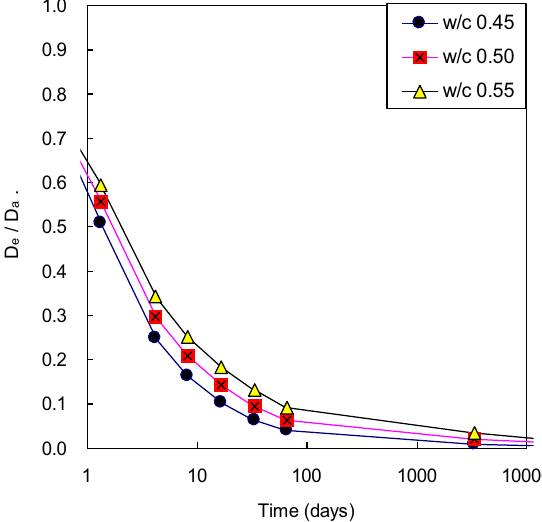
Fig. 7 Comparison of effective oxygen diffusivity of concrete (D e ) and apparent oxygen diffusivity (D a ) of concrete.